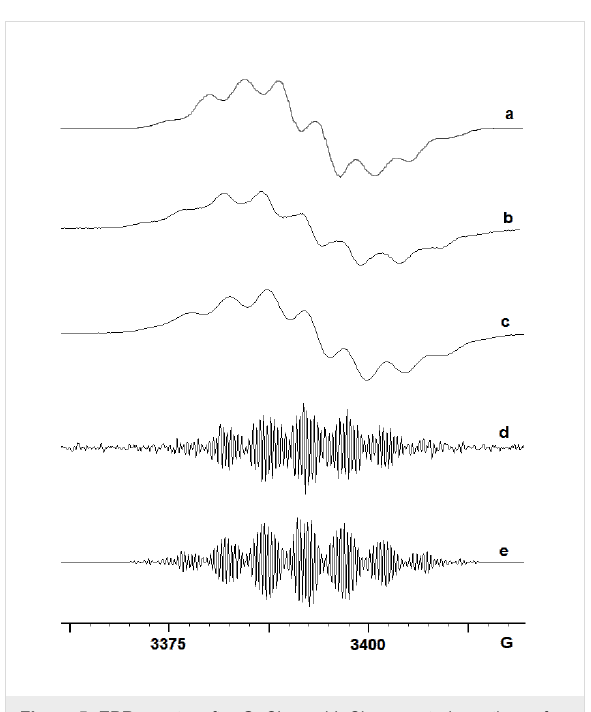
Figure 5: EPR spectra after GaCl 3 - and InCl 3 -promoted reactions of 2-methoxyphenyl azide 5 . (a) 1st derivative spectrum of 17b +• from 5 with GaCl 3 in DCM. (b) 1st derivative spectrum of 17b +• from 5 with HInCl 2 in THF at 300 K. (c) 1st derivative spectrum of 18 +• from 5 with InCl 3 in DCM at 300 K. (d) 1st derivative spectrum of 18 +• from 5 with